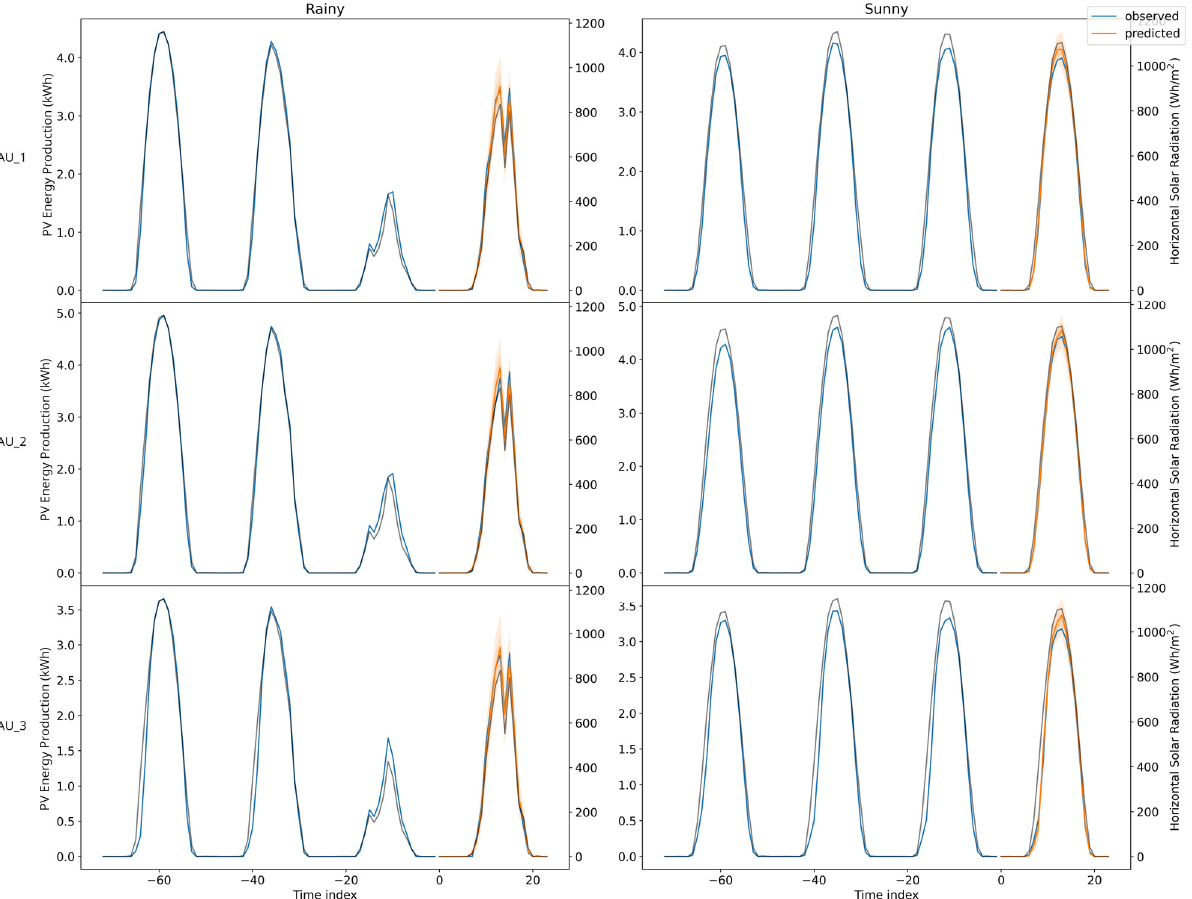
Figure 10. Observed and predicted PV energy production forecasting for a sunny and a rainy day in the facilities from Australia. Global horizontal radiation is represented in grey. For AU_1 on a rainy day, the maximum solar energy production predicted is 3.50 kWh, where 3.22 kWh and 3.76 kWh are the 0.1 and 0.9 percentiles, respectively. The interval between the tenth and the ninetieth percentile is 0.54 kWh. Considering the hours with energy production, the mean and standard deviation for half of this interval are 0.19 kWh and 0.07 kWh, respectively, with a maximum value of 0.27 kWh and a mini- mum of 0.07 kWh. For the example of a sunny day, the value predicted for the hour with maximum solar output is 4.05 kWh. In this case, the mean and standard deviation of the mid-range between the considered percentiles during the day is 0.12 kWh and 0.03